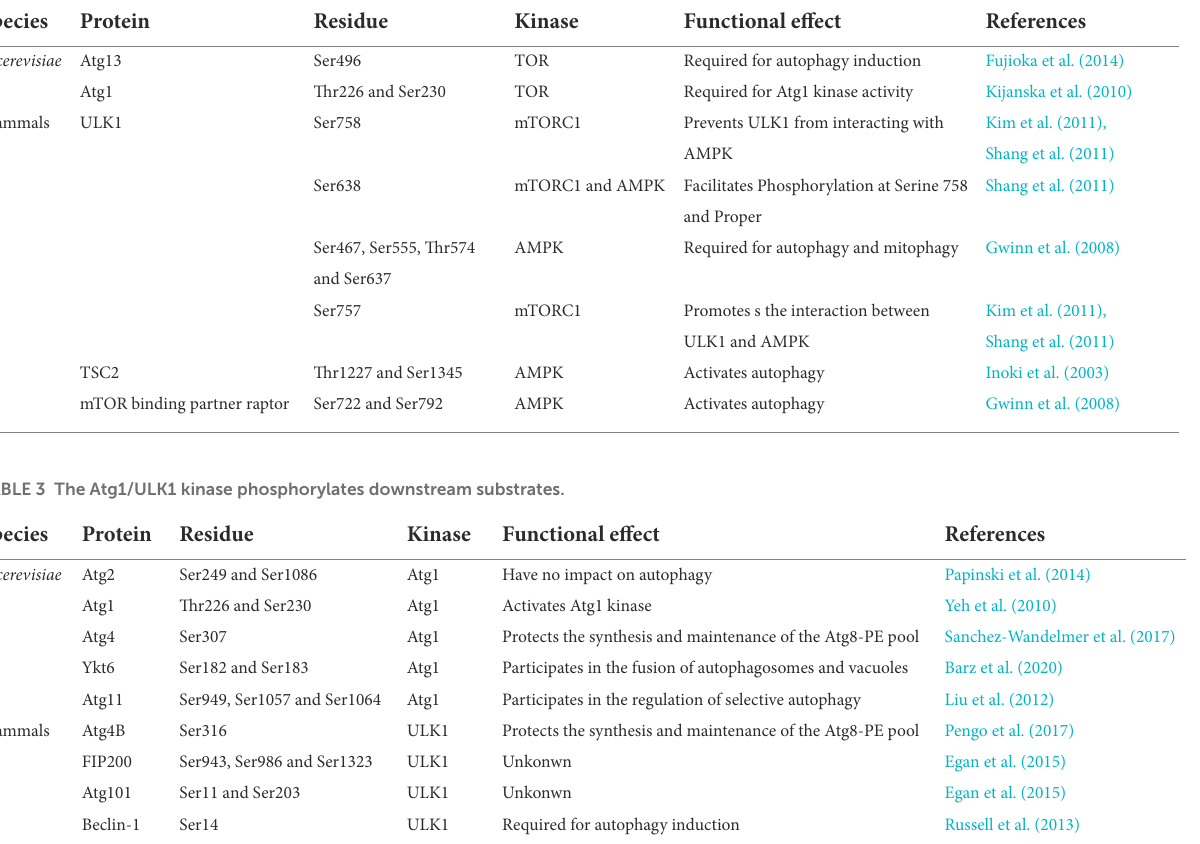
TABLE 2 The Atg1/ULK1 complex is phosphorylated by upstream kinases TOR and